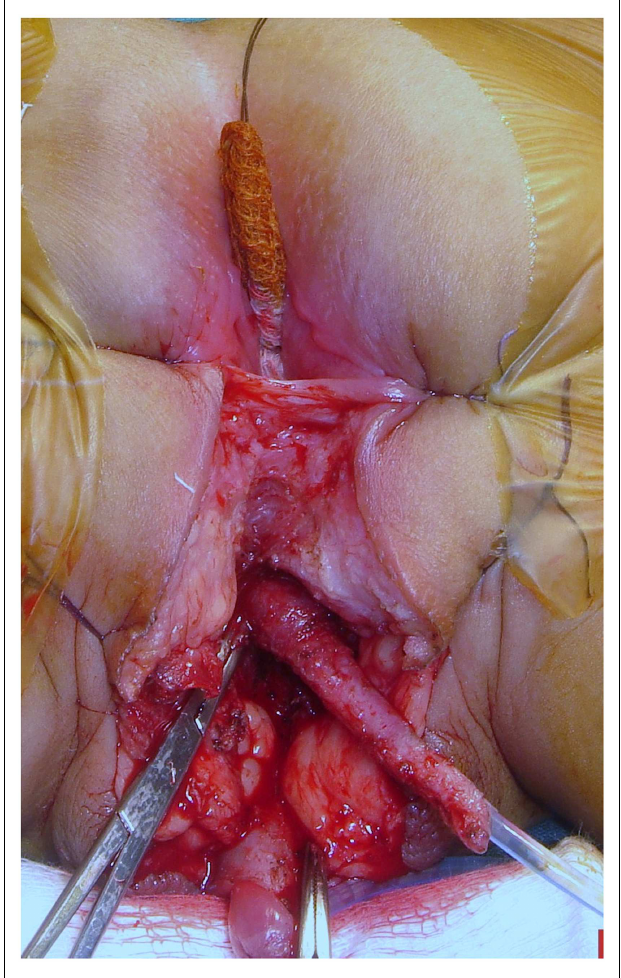
FIGURE 5 | Prone position .The modified anterior sagittal transrectal approach (ASTRA). Note that the balloon catheter was previously inserted in vagina.The midline perineal incision is extended around the anocutaneous junction between 4 and 8h to get better exposure.The rectum is retracted using sutures and a retractor to avoid opening the anterior rectal wall as proposed in the ASTRA technique.